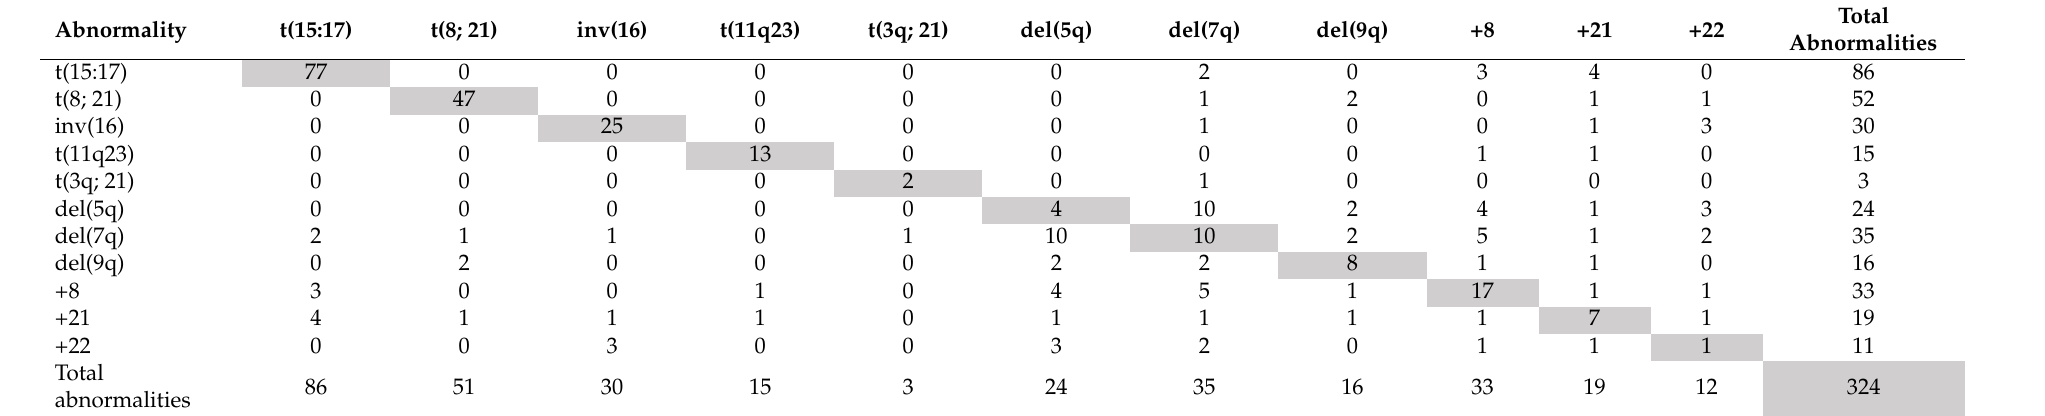
Table 4. Distribution of 252 patients with ≥ 1 major chromosomal aberration in AML.